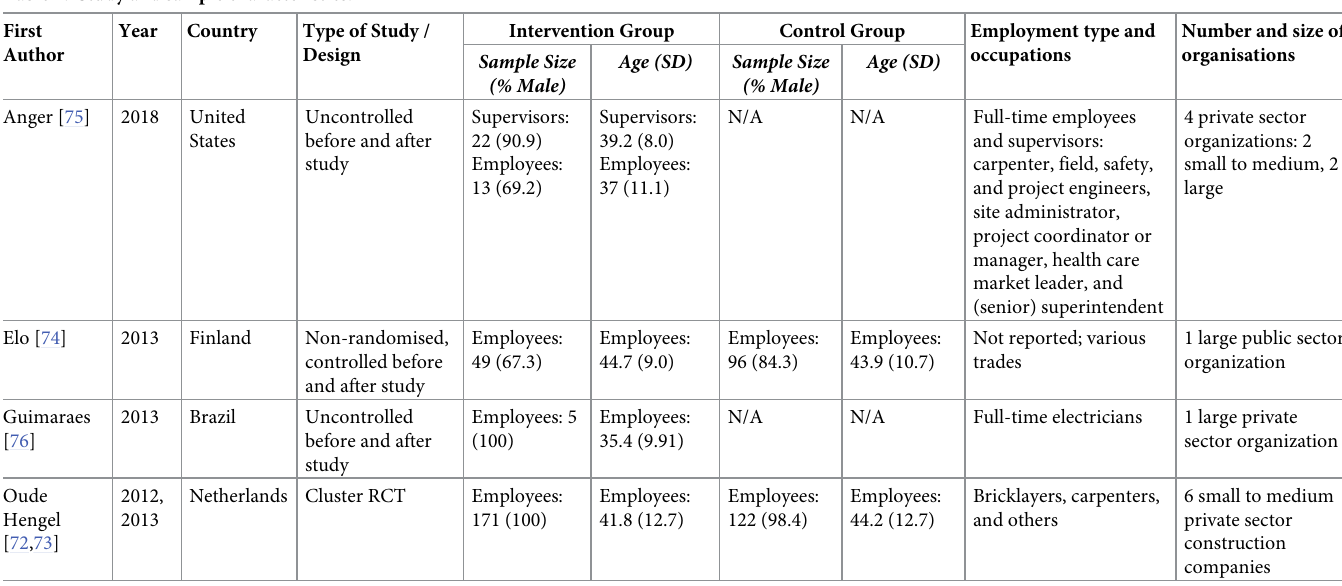
Table 2. Study and sample